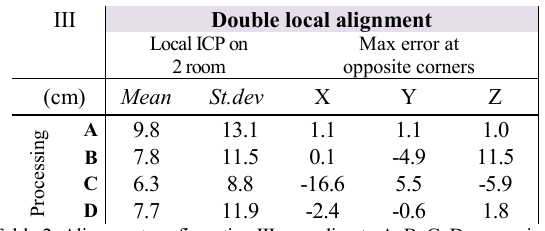
Table 2. Alignment configuration III according to A, B, C, D processings